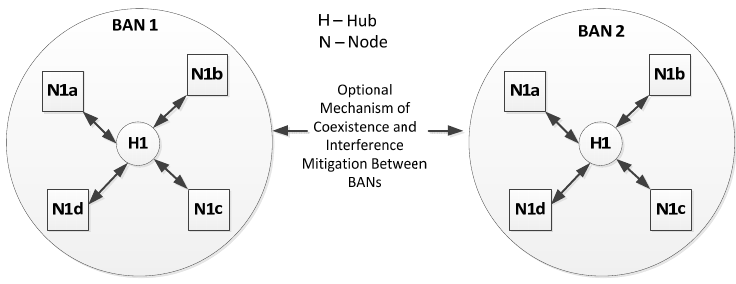
Figure 13. Network Topology (One-Hop Star) [9].